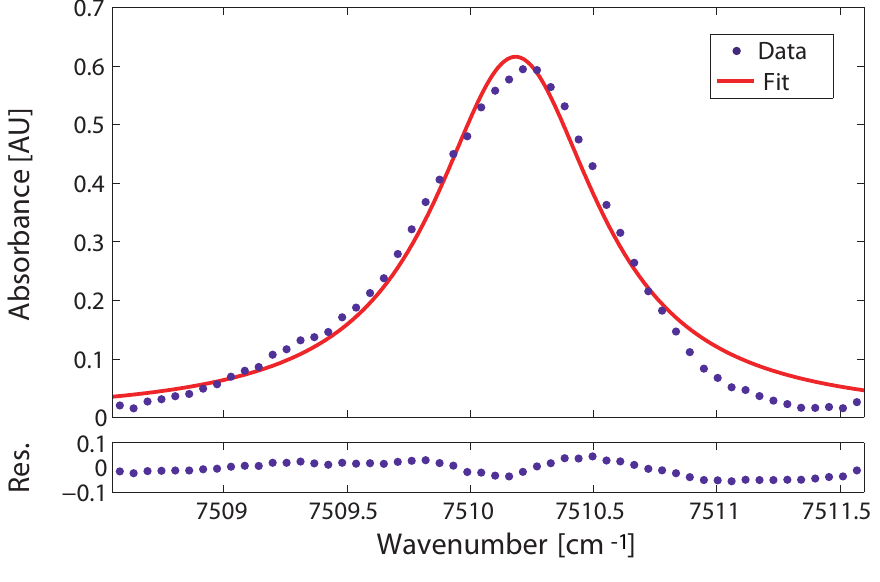
Figure 6. Upper panel: Single Lorentzian fit (solid curve) and experimental absorbance data (dots) for the Q-branch at room temperature, relative pressure of 1 bar and methane concentration of 18750 ppmv. Lower panel: Residuals of the